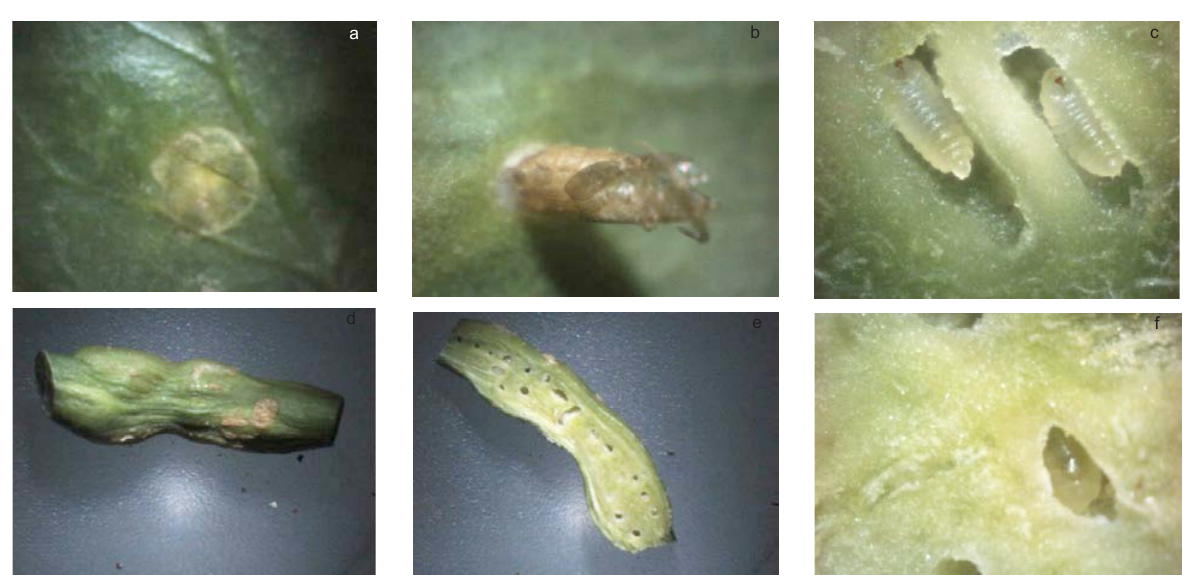
Image 1. Leaf gall and cecidomyiid larvae. © Moawia Mohamed (a) leaf gall, (b) pupal skin on exit hole on underside of the leaf, (c) leaf gall section showing two chambers and cecidomyiid larvae, (d) stem galls, (e) longitudinal section through stem galls and (f) cecidomyiid larva in a stem gall